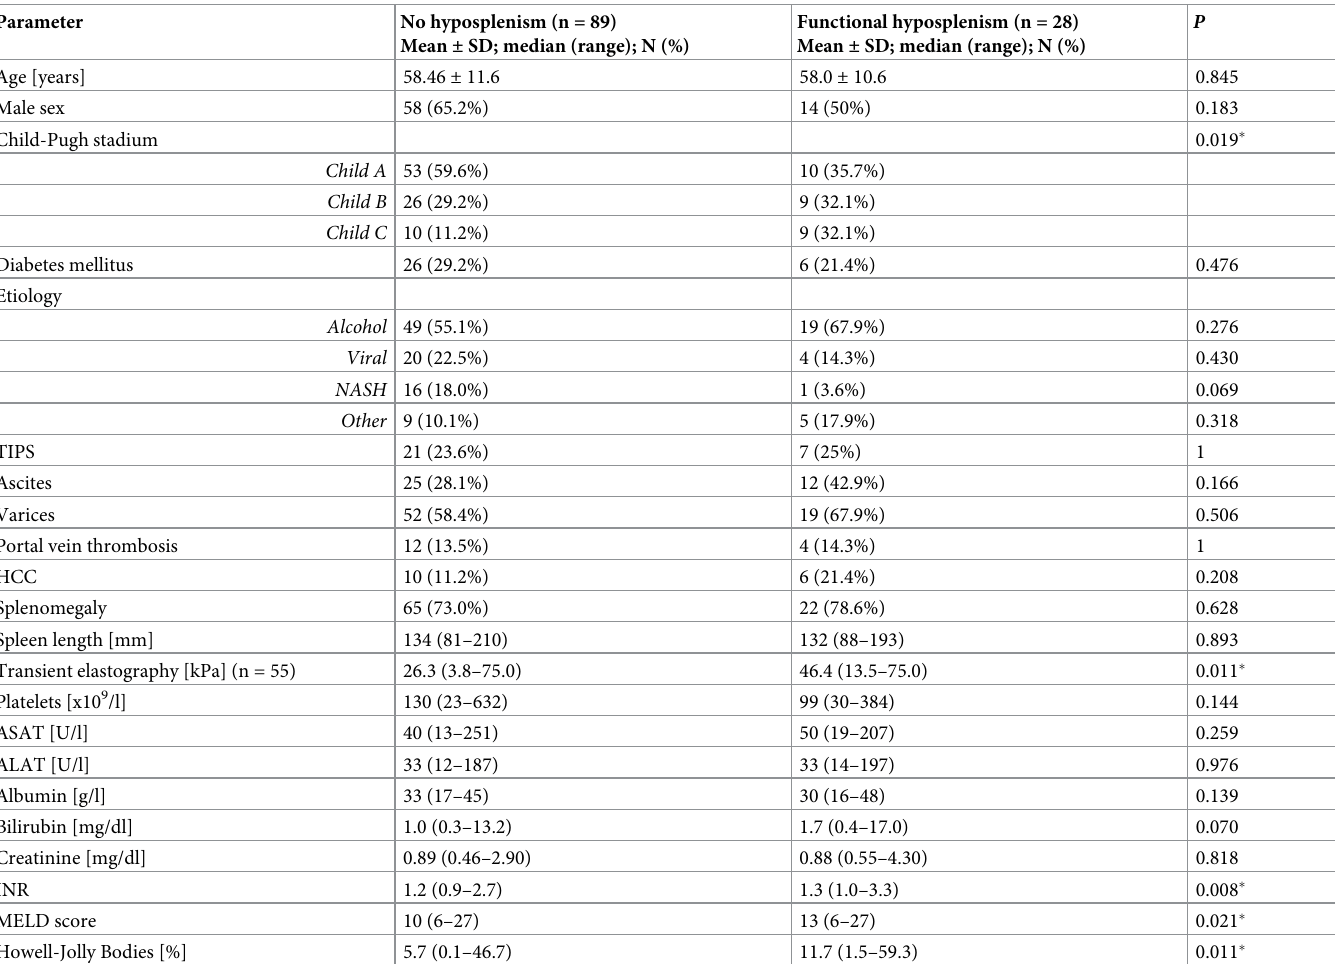
Table 1. Comparison of patients with and without functional